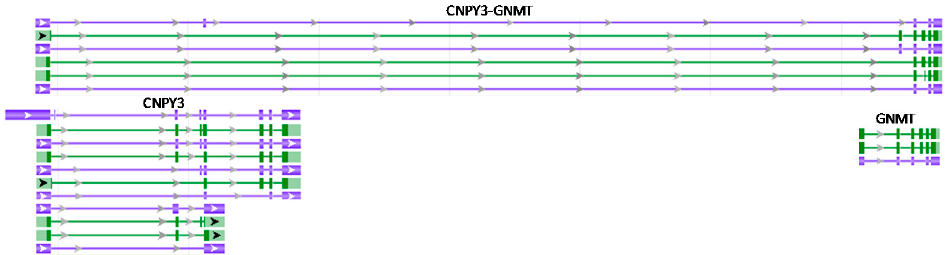
Figure 5. An illustration copied and modified from the NCBI database showing multiple mRNAs and noncoding RNAs of the CNPY3 , GNMT, and CNPY3-GNMT genes in the human 6p21.1 region.